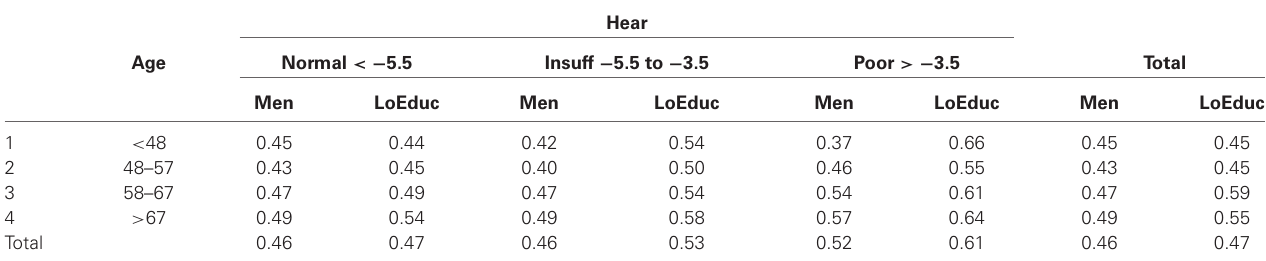
Table 2 | Proportions of men (1st fraction in each cell of the table) and proportions of persons with an education other than University, College, A level, AS level (2nd fraction) in the Age by Hearing status